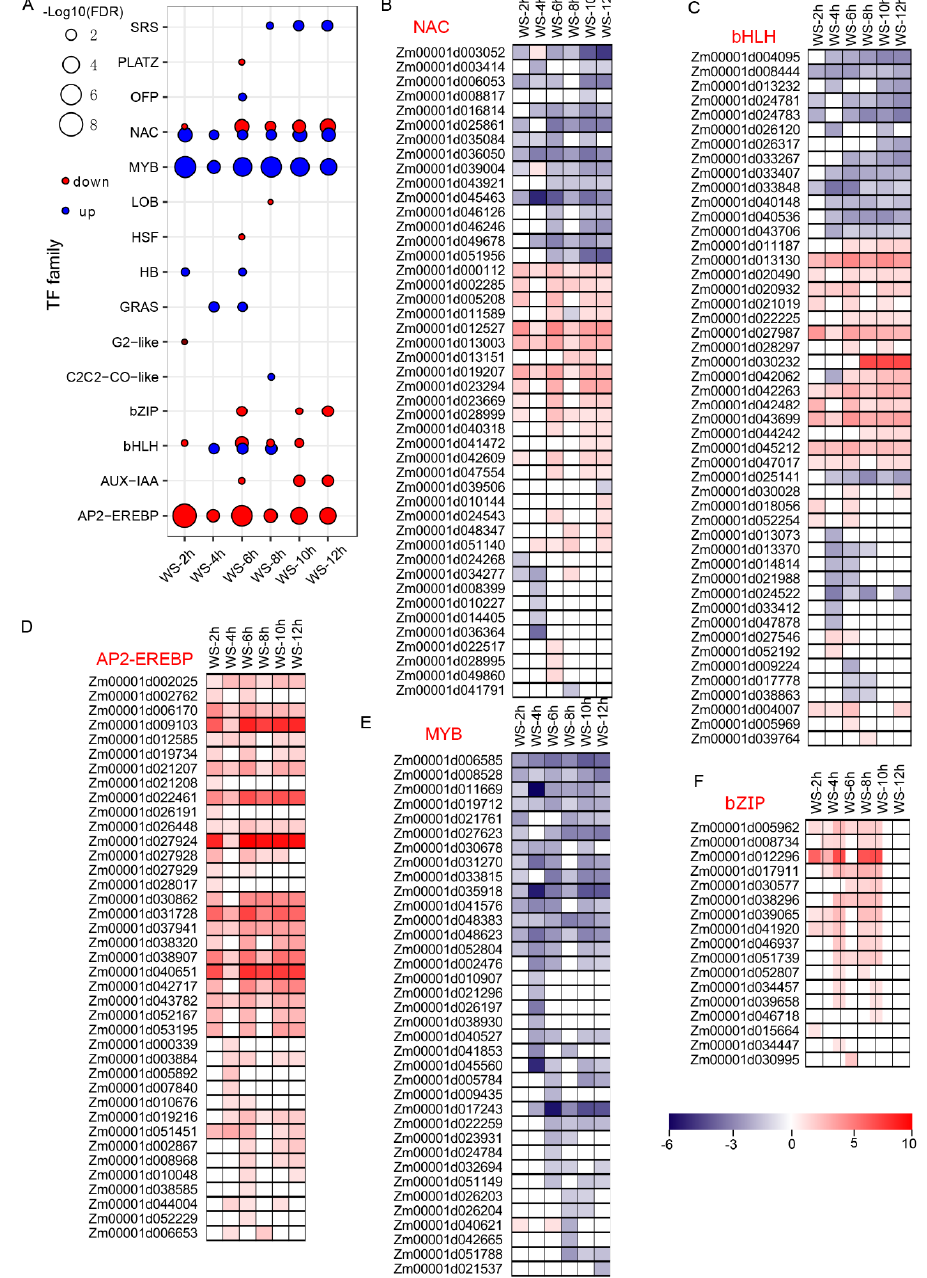
Figure 2. The enrichment analysis of transcription factors (TFs) after waterlogging stress (WS). The TF members of each family were downloaded from PlantTFDB (http://planttfdb.cbi.pku.edu.cn/). ( A ) The bubble chart shows the significantly enriched TF family in up- and down-regulated catalogs. ( B ) The gene list of NAC TFs enriched after WS treatment. ( C ) The gene list of bHLH TFs enriched after WS treatment. ( D ) The gene list of AP2-EREBP TFs enriched after WS treatment. ( E ) The gene list of MYB TFs enriched after WS treatment. ( F ) The gene list of bZIP TFs enriched after WS treatment.